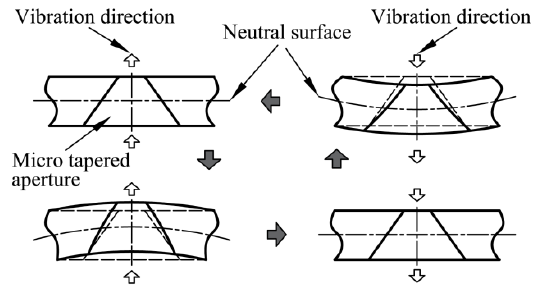
Figure 2. Dynamic cone angle developed by deformation of the micro-tapered aperture.